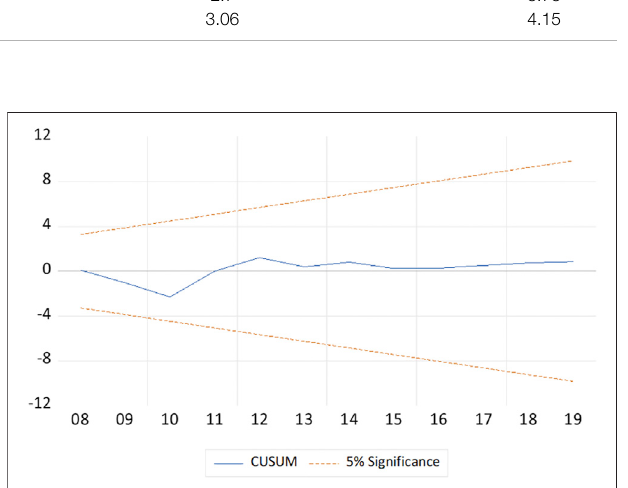
FIGURE 3 | Plot of the cumulative sum of recursive